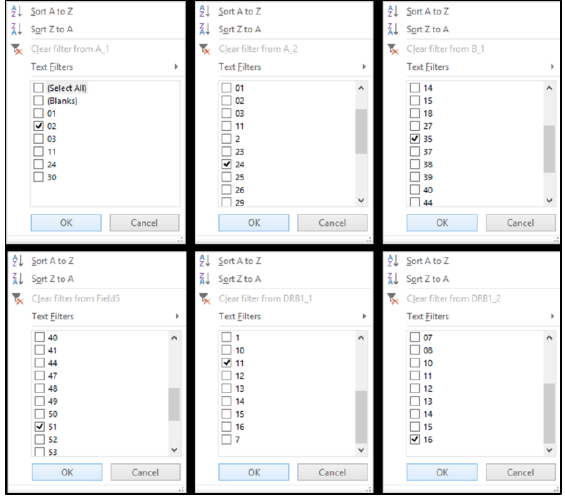
Figure 3. A screenshot of the filters tab that is available in each column of the “VP database”